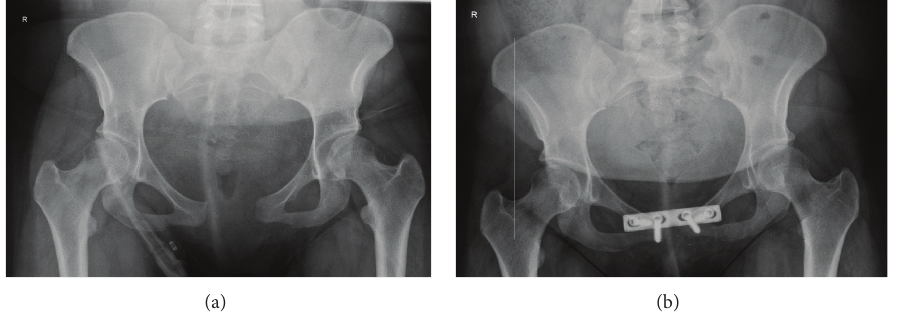
Figure 1: X-ray of the pelvis with a pubic symphysis separation is shown in (a). X-ray of the pelvis after surgical fixation of the symphysis is shown in (b).